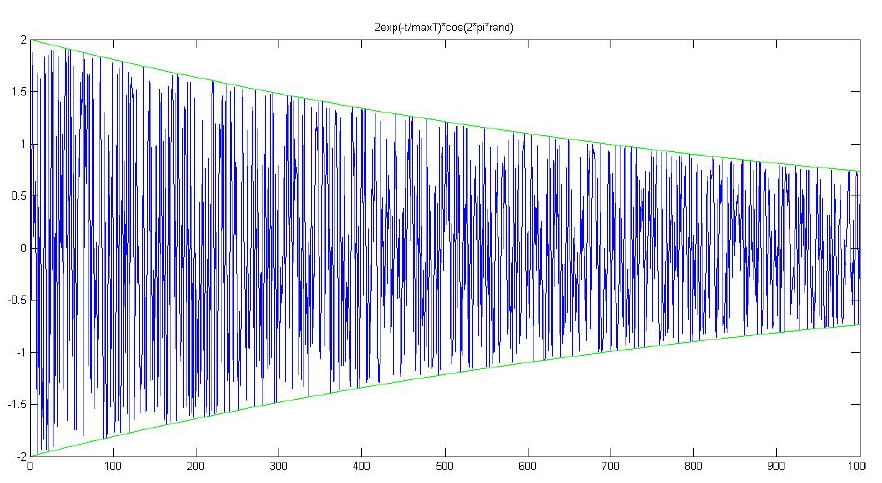
Figure 2. 𝑝𝑒𝑛𝑑 𝑖𝑑 (𝑡) Magnitude of